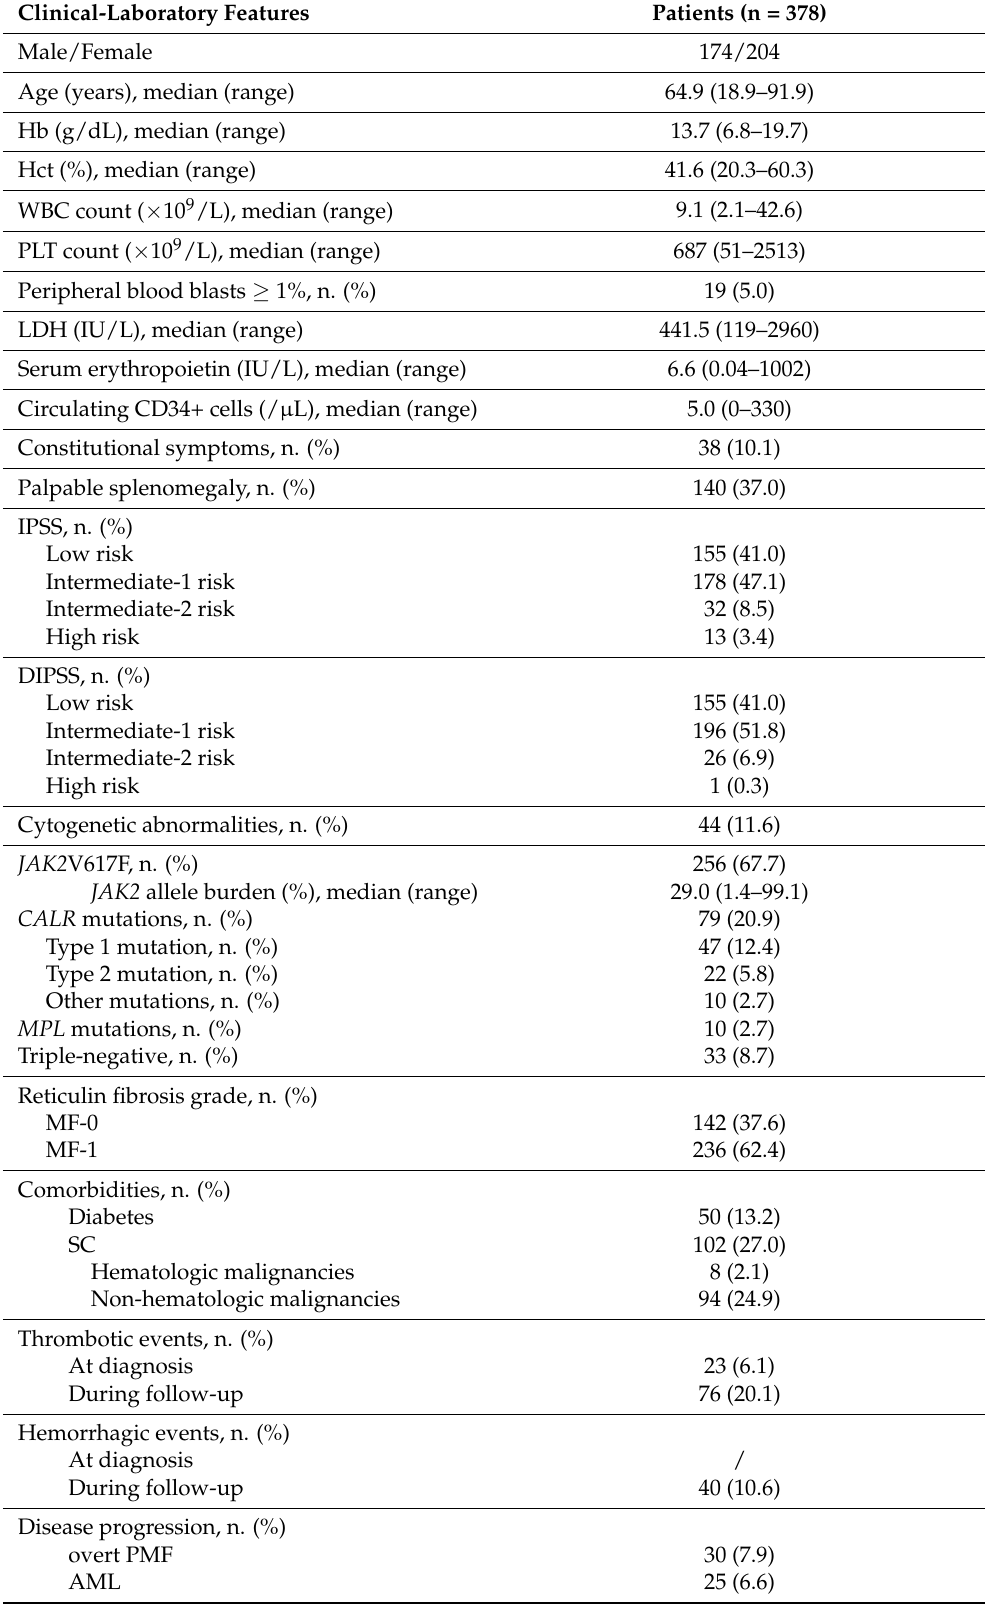
Table 1. Baseline clinical and laboratory features of 378 pre-PMF